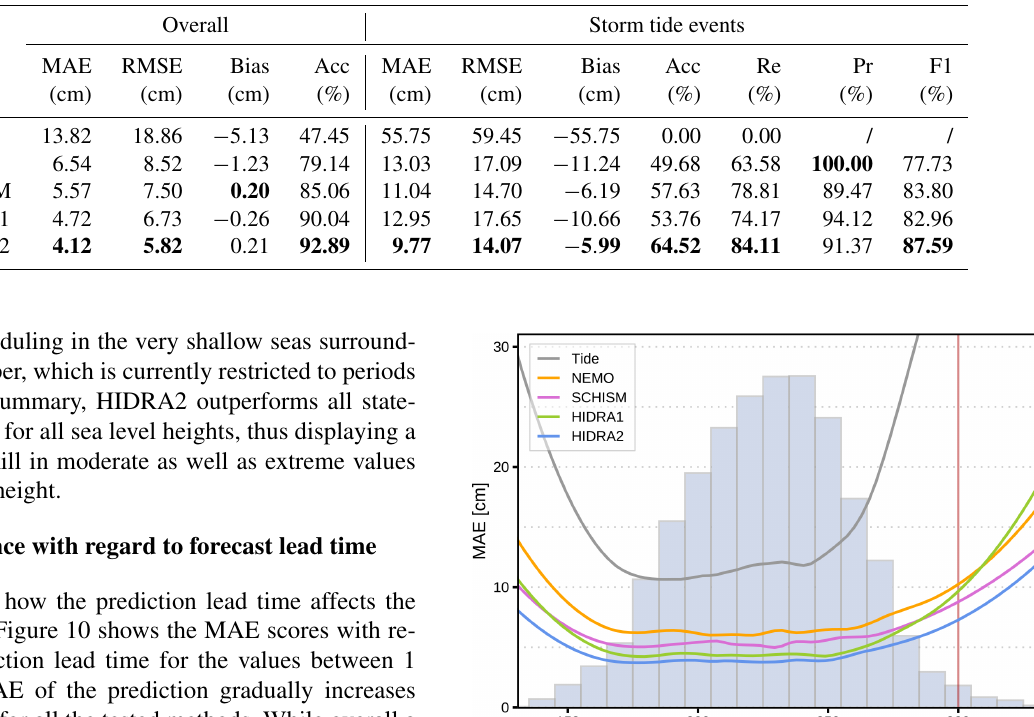
Figure 8. Mean absolute error (MAE) of ablated HIDRA2 designs evaluated over all sea level bins. Vertical red line indicates the flooding threshold in Piran. Performances of all the models were evaluated on a 1 June 2019–31 December 2020 dataset, which is completely independent of the training data. Table 2. Performance of HIDRA1, HIDRA2, NEMO and SCHISM over all sea level bins (the Overall column) and only during storm tide events ( Storm tide events column). Tidal forecast is included for reference. The evaluation period spans 1 June 2019–31 December 2020, which is completely independent of the training data. The best scores are formatted in bold.